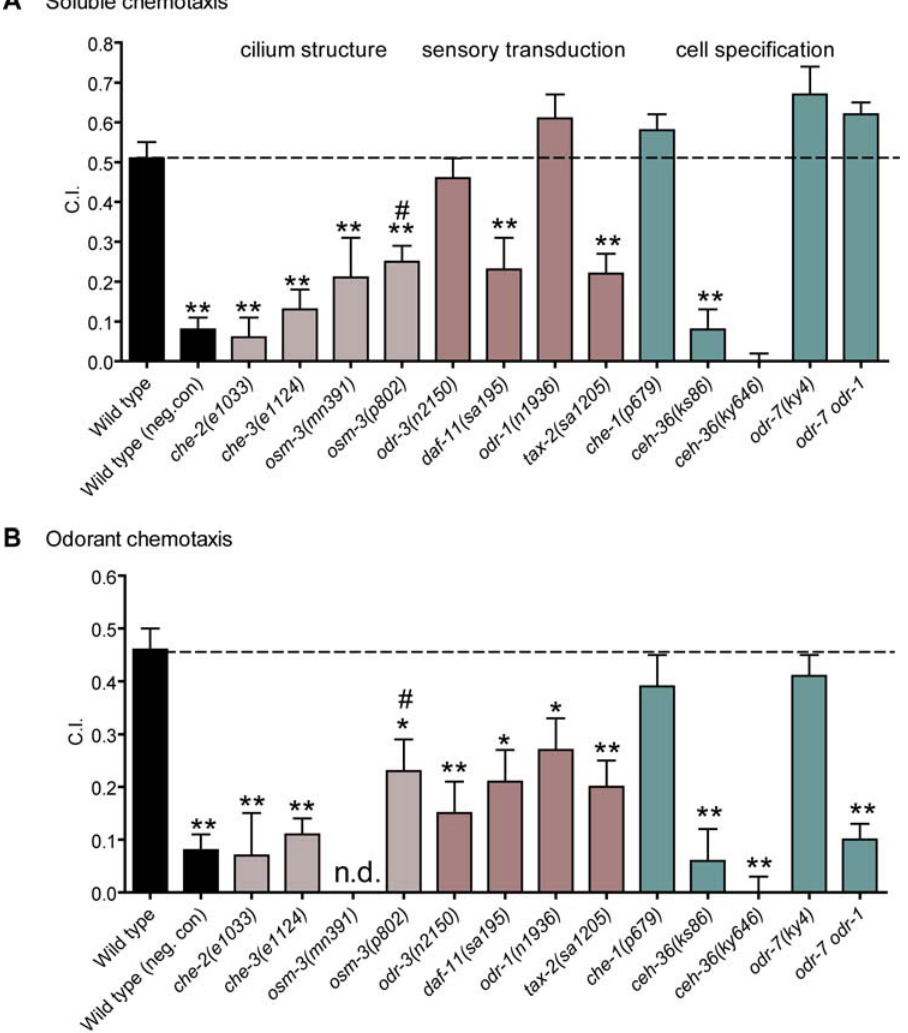
Figure 2. Genetic analysis of chemotaxis to NH 4 Ac presented in water soluble or odorant form. (A) Water soluble chemotaxis assays. Chemotaxis index is plotted vs. strain for assays in which radial gradients of NH 4 Ac were established by diffusion in the agar. (B) Odorant NH 4 Ac assays. Chemotaxis index is plotted vs. strain for assays in which a droplet of NH 4 Ac (10 m L, 7.5 M) was suspended from the lid of the plate. In A and B, each bar represents the mean of at least 8 independent assays; n.d. means no data. Wild type (neg. con) is a negative control assay with no attractant on plate. Statistics: * p , 0.05 and ** p , 0.01 in a one way ANOVA and Dunnet’s post test comparing all means to the wild-type (N2) mean; # p , 0.05 in a one-way ANOVA with Dunnet’s post test comparing che-2(e1033) , che-3(e1124) , and osm-3(p802) to the negative